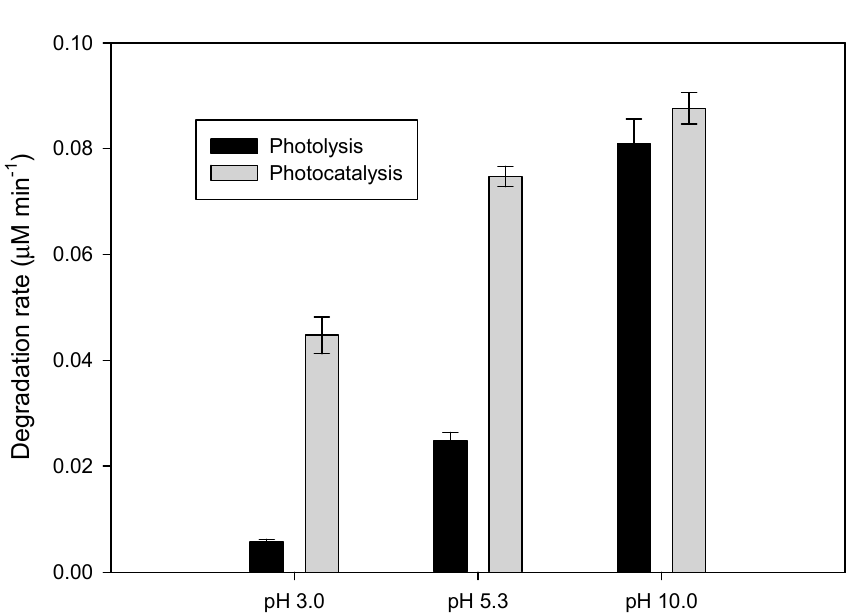
Figure 5. Effect of pH on the degradation of LEV by the photolytic (UVA alone) and photocatalytic (UVA/CdS) processes. Experimental conditions: [LEV] = 13.8 µM, [CdS] = 0.5 g L − 1 , and UVA intensity = 40 W m − 2 . Table 2. Composition of the simulated urine 1 .